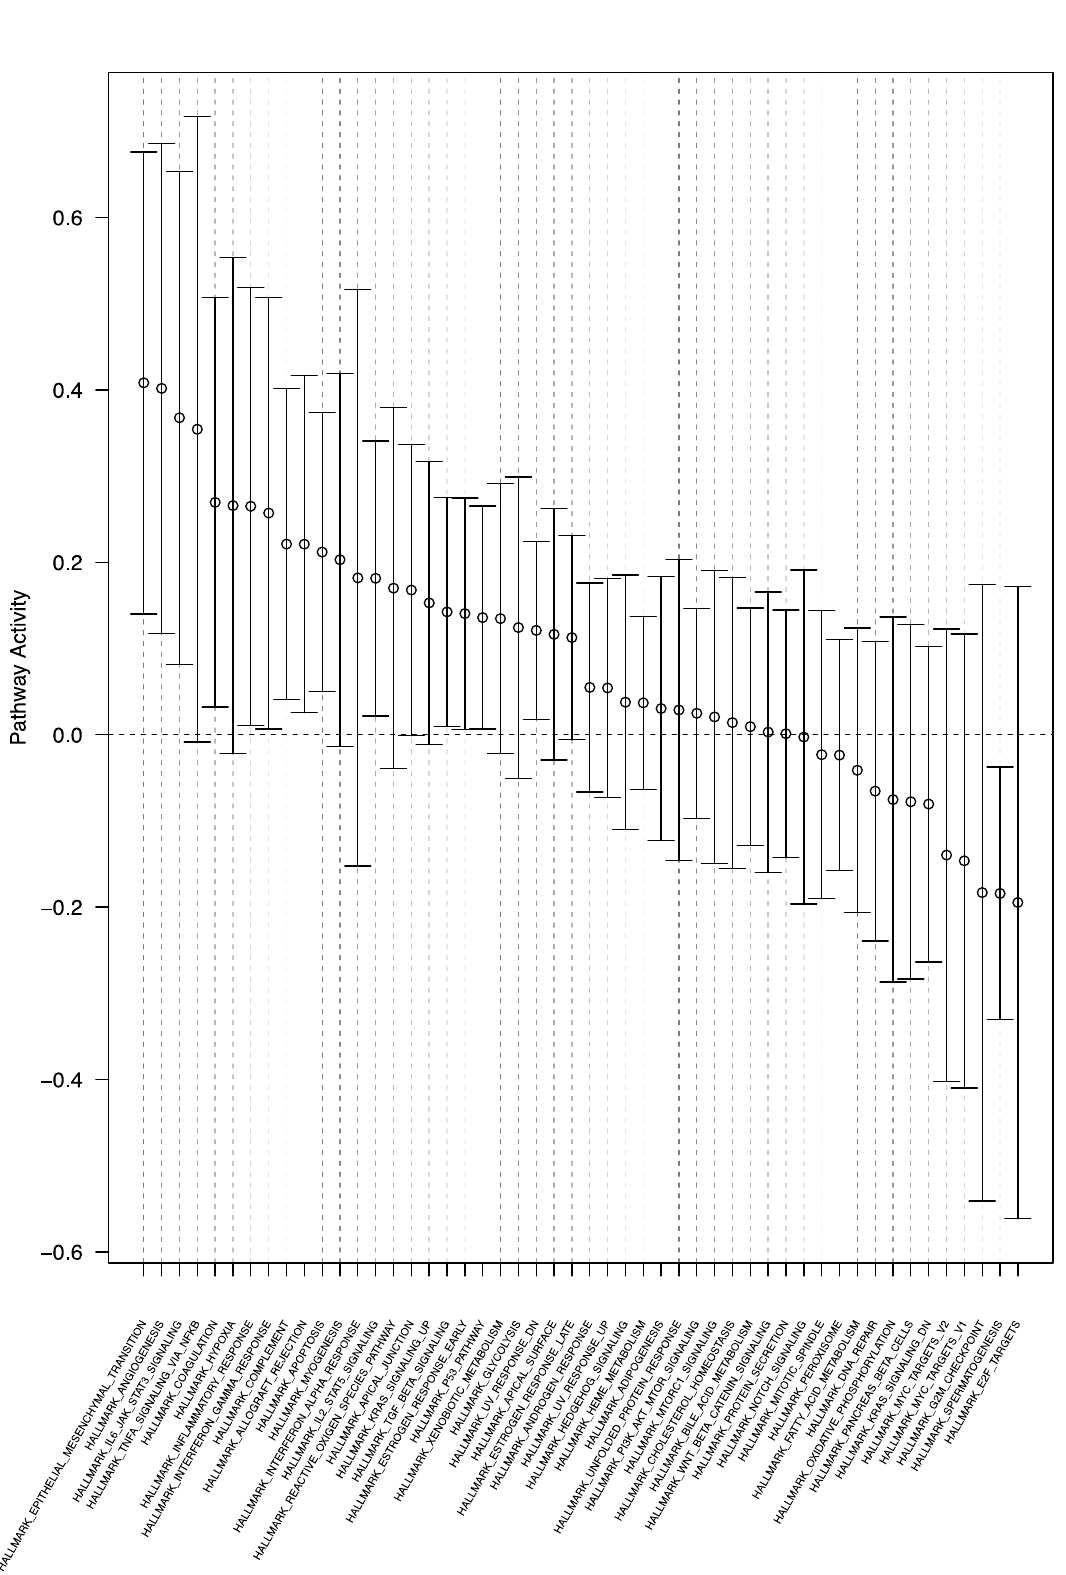
Figure 3. Pathway enrichment plot of the within SVZ contacting glioblastoma ( withinSVZ- samples vs. outsideSVZ- samples) analysis. Gene set enrichment analysis of the withinSVZ- samples vs. outsideSVZ -samples showed differential enrichment of 24 gene sets ( p < 0.05, FDR < 0.25), which are shown on the x -axis. The relative gene set activity (log fold change) is displayed on the y -axis. The 95% confidence intervals are represented by the horizontal bars. Most gene sets were enriched in the withinSVZ -samples group, as shown by their positive log fold changes.